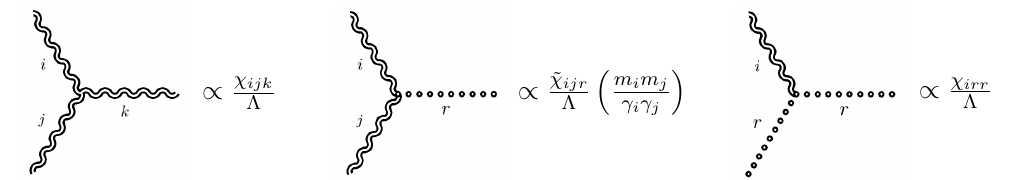
Figure 1 . Cubic interactions between gravitons and